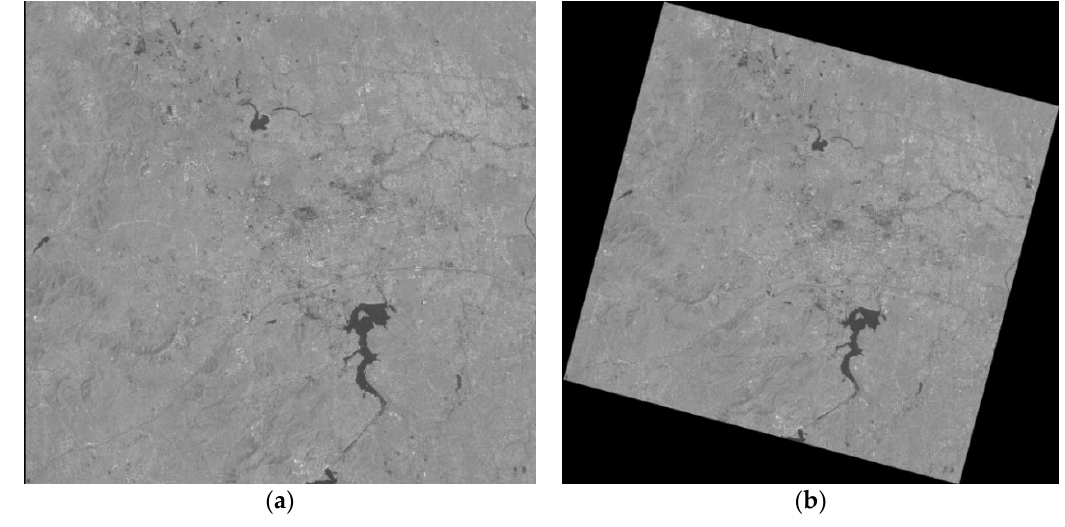
Figure 15. Example of the input and output of the GC processing: ( a ) raw image and ( b ) georeferenced image. Table 5. Root-mean-square errors (RMSEs) between the CPU processors and the DSP/FPGA co-processors. Processor RMSE (before Rounding) RMSE (after